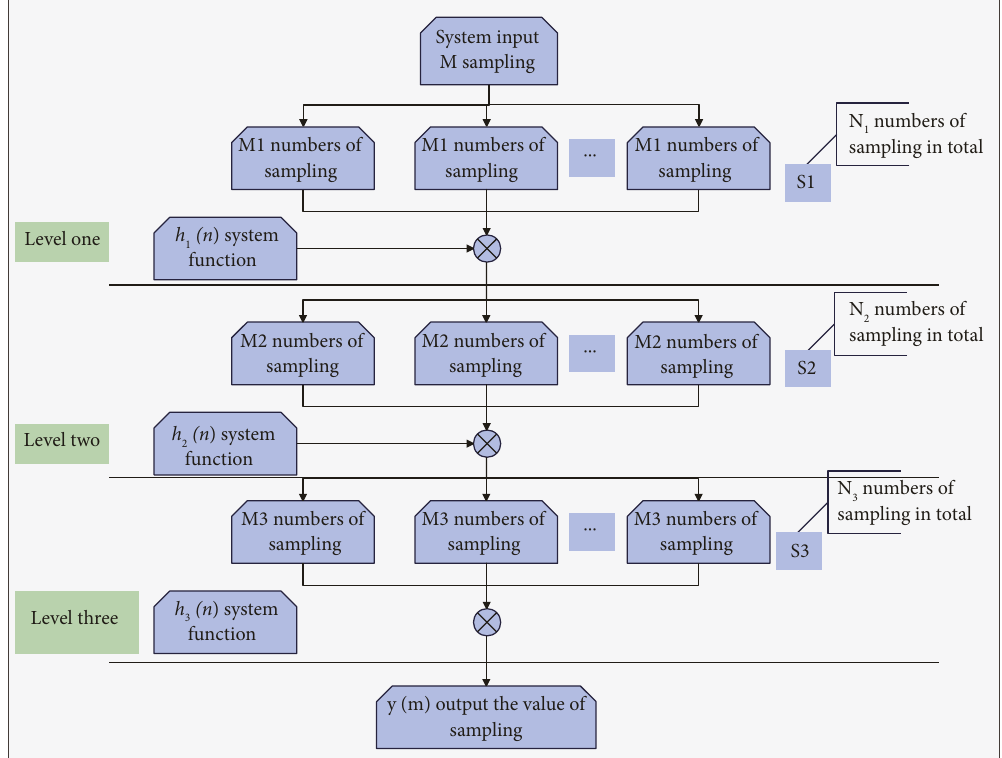
Figure 6: Structure diagram of the control system of the three-stage extraction